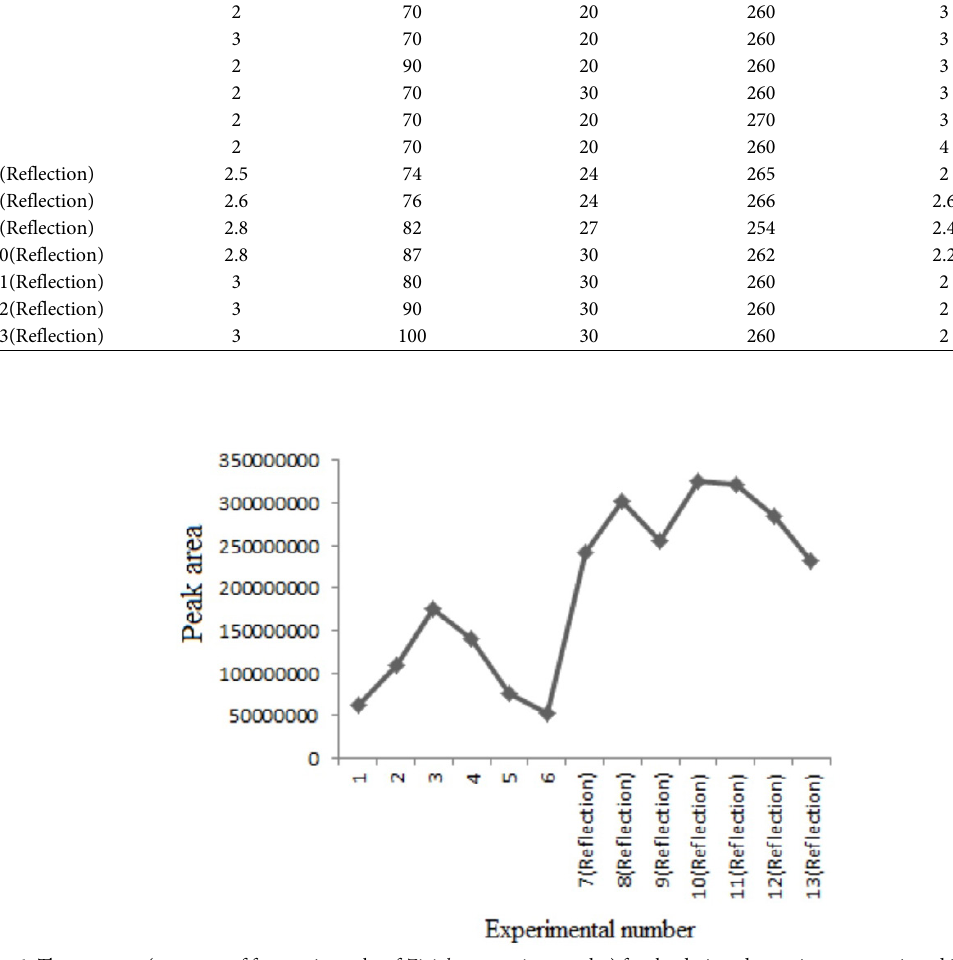
Fig. 1 . The response (sum area of four main peaks of Ziziphora tenuior samples) for the designed experiments mentioned in Table